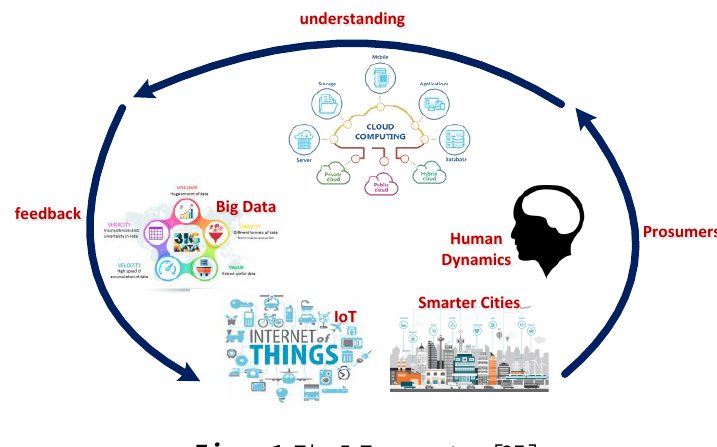
Figure 1. The IoT ecosystem